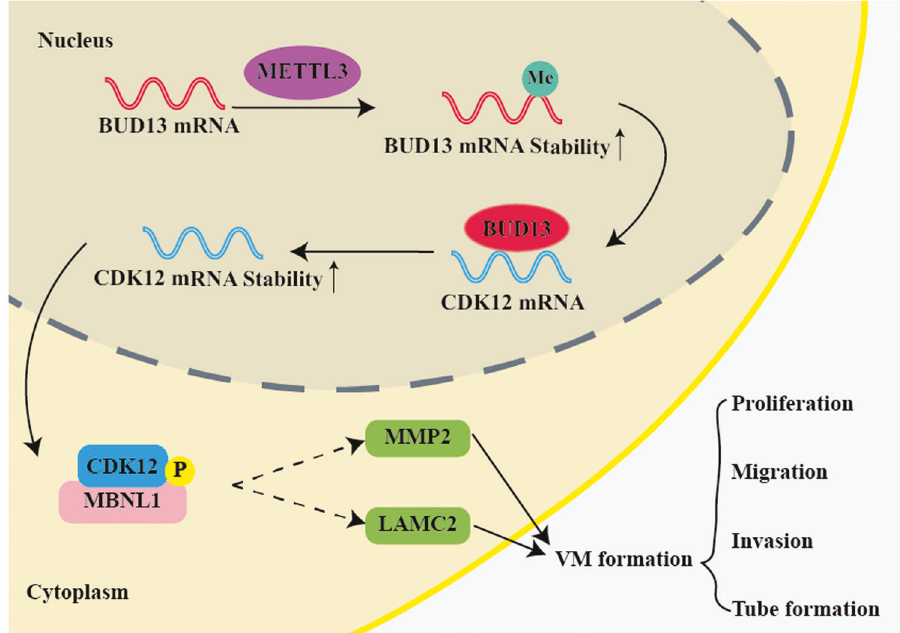
Fig. 7 The schematic diagram about the regulating process of BUD13/CDK12/MBNL1 axis on VM formation of GBM. METTL3 enhanced the stability of BUD13 mRNA and upregulated its expression through m6A methylation. BUD13 enhanced the stability of CDK12 mRNA and upregulated its expression. CDK12 phosphorylating MBNL1 regulated proliferation, migration, invasion, and tube formation of